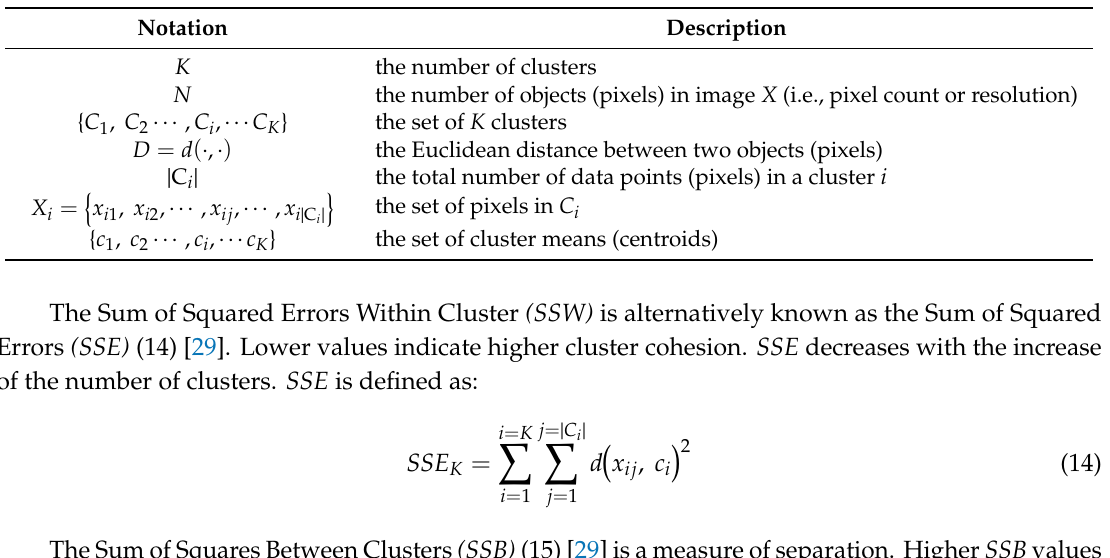
Table 5. Basic notations and definitions for the internal